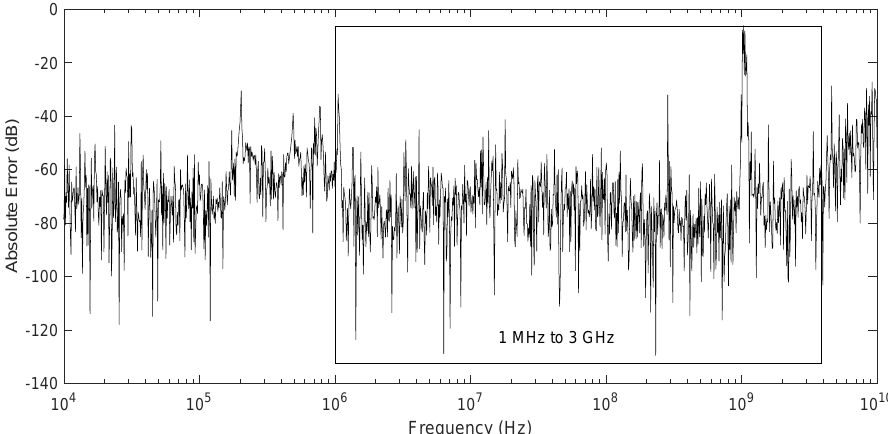
Figure 18. Absolute error of ROM generated using RNSZ of order N = 180 compared to original system frequency response of a spiral inductor (order n = 191). The mean absolute error is − 73.98 dB from 1 MHz to 3 GHz frequencies.